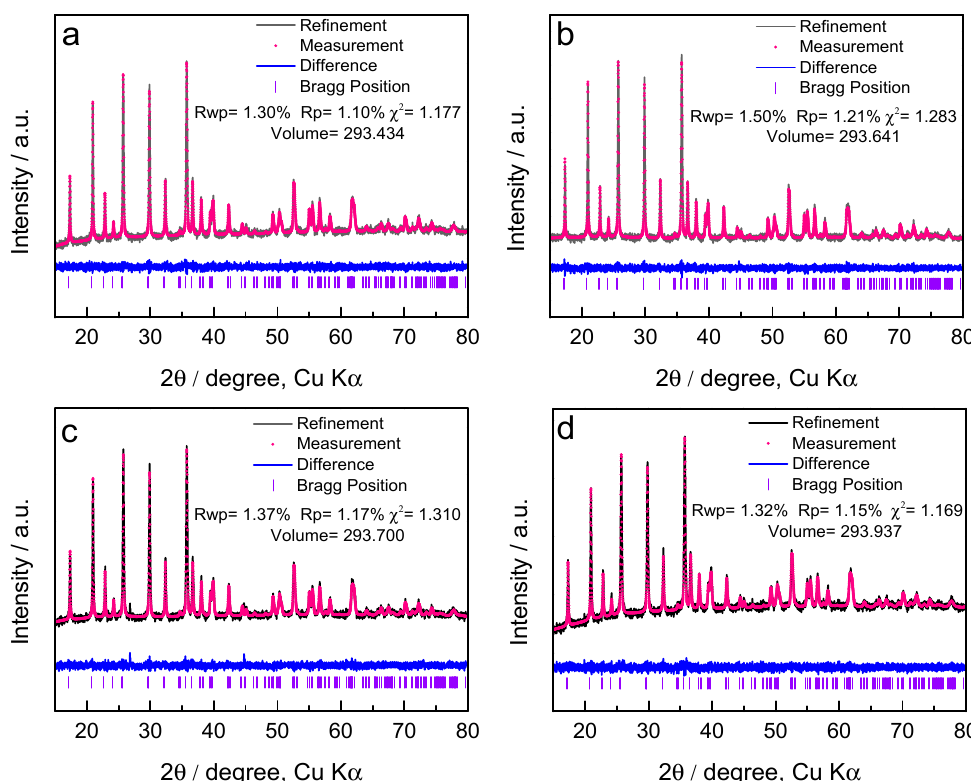
Figure 6. XRD spectra of LiFePO 4 samples prepared at spray drying temperature of ( a ) 200 °C, ( b ) 250 °C, ( c ) 300 °C and ( d ) 350 °C, as well as Rietveld refinement of Pnma. The black line, the red circle and the blue line correspond to the observed pattern, the calculated diffraction pattern and the difference pattern.